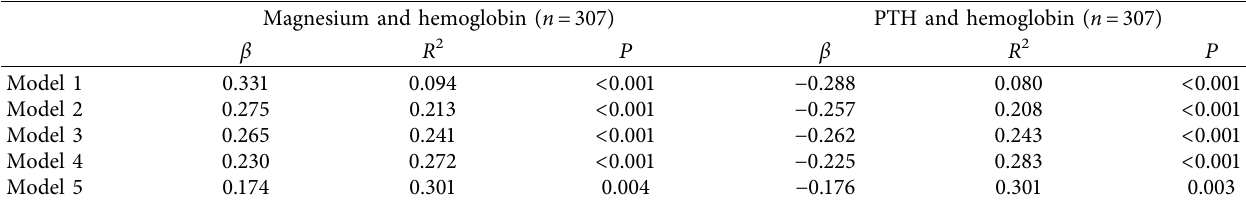
Model 1: general regression analysis; Model 2: adjusted for age, sex, duration of disease, and BMI; Model 3: adjusted for age, sex, duration of disease, BMI, albumin, and calcium; Model 4: adjusted for age, sex, duration of disease, BMI, albumin, calcium, and eGFR; Model 5: adjusted for age, sex, duration of disease, BMI, albumin, calcium, eGFR, and